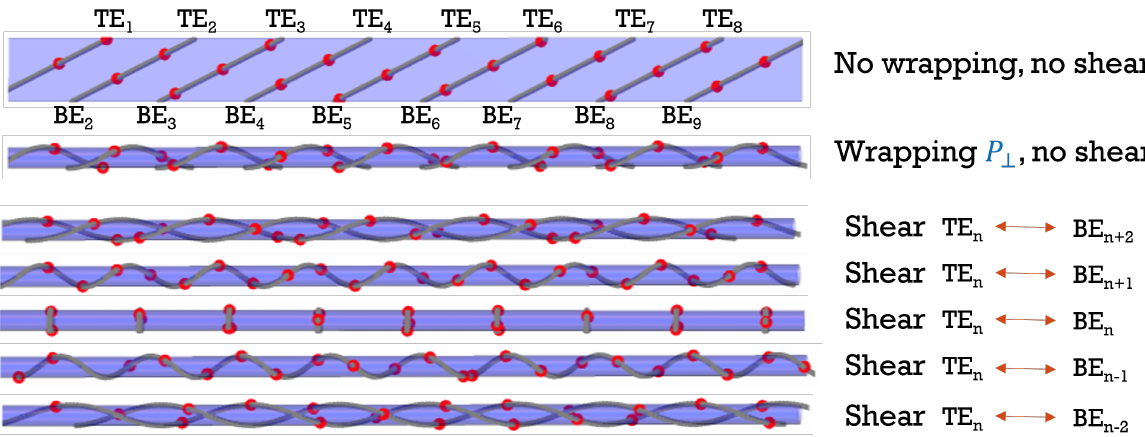
Figure 5. When the cut region is curved into a cylinder, different choices of shear connect different sections to make different helices. n helices are created when the shear connects each sections with its n th neighbors, rather than just its immediate neighbors.